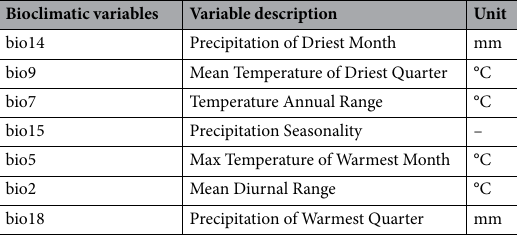
Table 1. The seven bioclimatic variables used for the MaxEnt